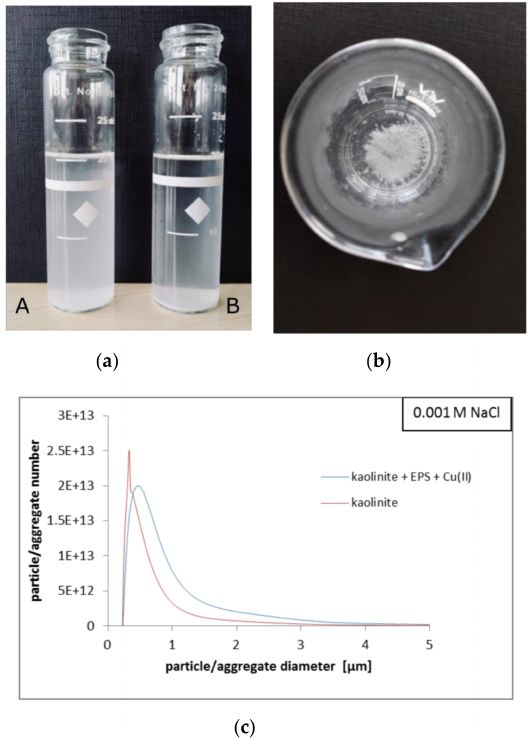
Figure 8. Photo of kaolinite suspension without(A) and with(B) EPS/Cu(II) ions after 15 min ( a ); photo of flocs formed in the kaolinite/Cu(II)/EPS/CaCl 2 system ( b ); particle/aggregate number vs. particle/aggregate diameter measured for kaolinite suspension without or with Cu(II) ions and EPS (100 mg/L) in 0.001 M NaCl ( c